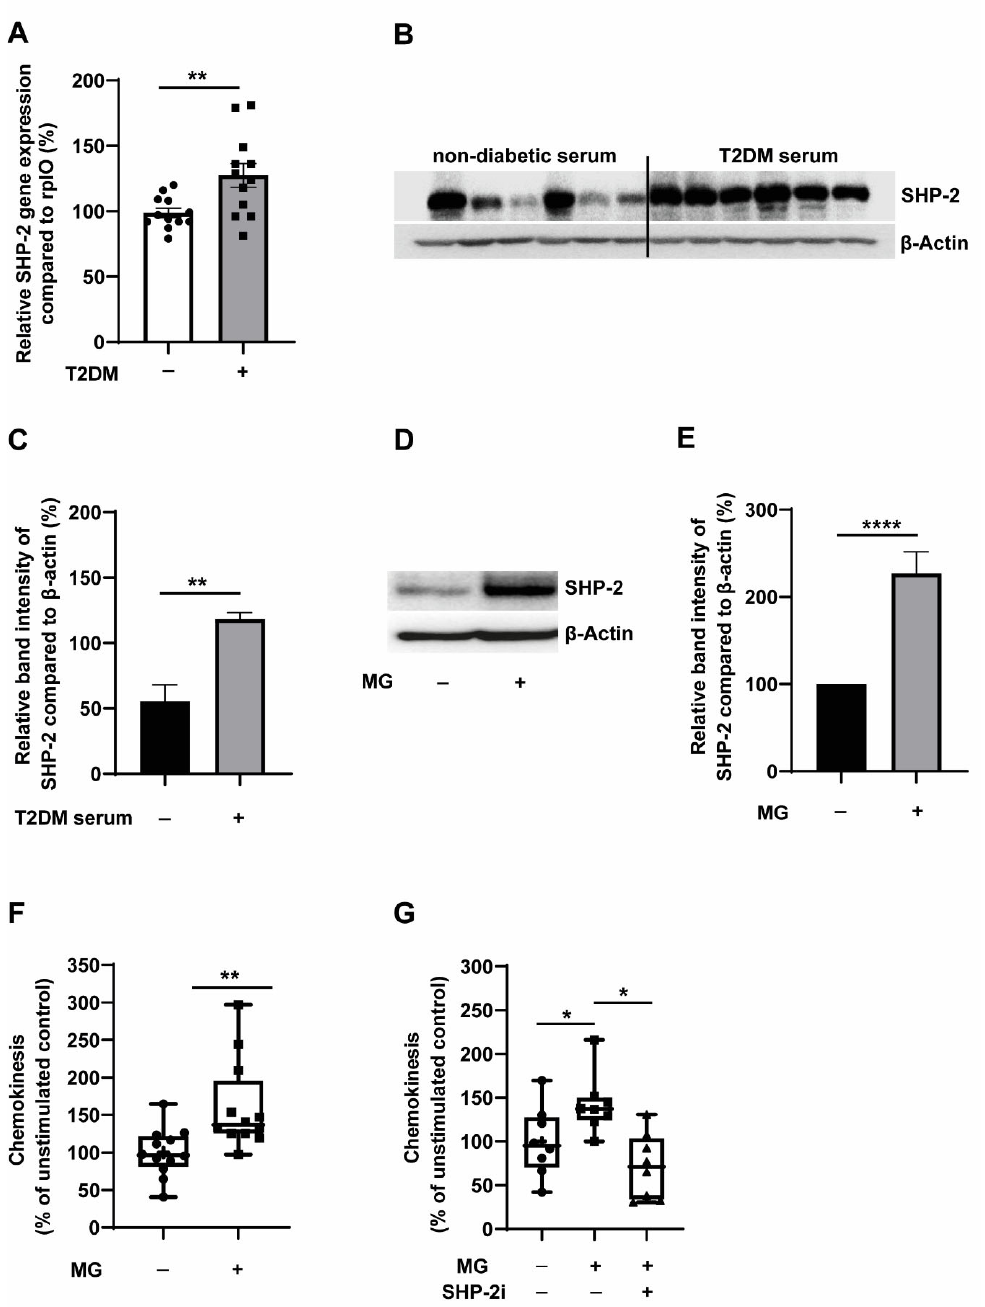
Figure 1. Hyperglycemia and glucose metabolite-induced upregulation of SHP-2 promotes ran- dom migration of monocytes . ( A ) Relative expression of SHP-2 mRNA compared to rplO. Primary monocytes isolated from the peripheral blood of non-T2DM ( n = 12) and T2DM ( n = 12) were used for the analysis. ( B ) Representative blots and ( C ) corresponding quantification. Expression of SHP-2 in relation to ß-actin. Exposure of monocytes with the serum of non-diabetic (black bar) or diabetic patients (grey bar) for 24 h. n = 6, respectively. ( D ) Representative blots and ( E ) corresponding quantification. Expression of SHP-2 in relation to ß-actin. Exposure of monocytes without (black bar) or with (grey bar) 300 µ M MG for 24 h. n = 12. ( F , G ) Bars display counted monocytes which migrated completely through the membrane during transwell migration. Circles (Control), squares (exposure with 300 µ M MG for 24 hrs) and triangles (exposure with 300 µ M MG and treatment with SHP-2i, 700 nM SHP099) represent counted monocytes of each experiment in percentage compared to the mean value of unstimulated control. ( E ) n = 12, ( F ) n = 8. * p < 0,05, ** p < 0.01, **** p <